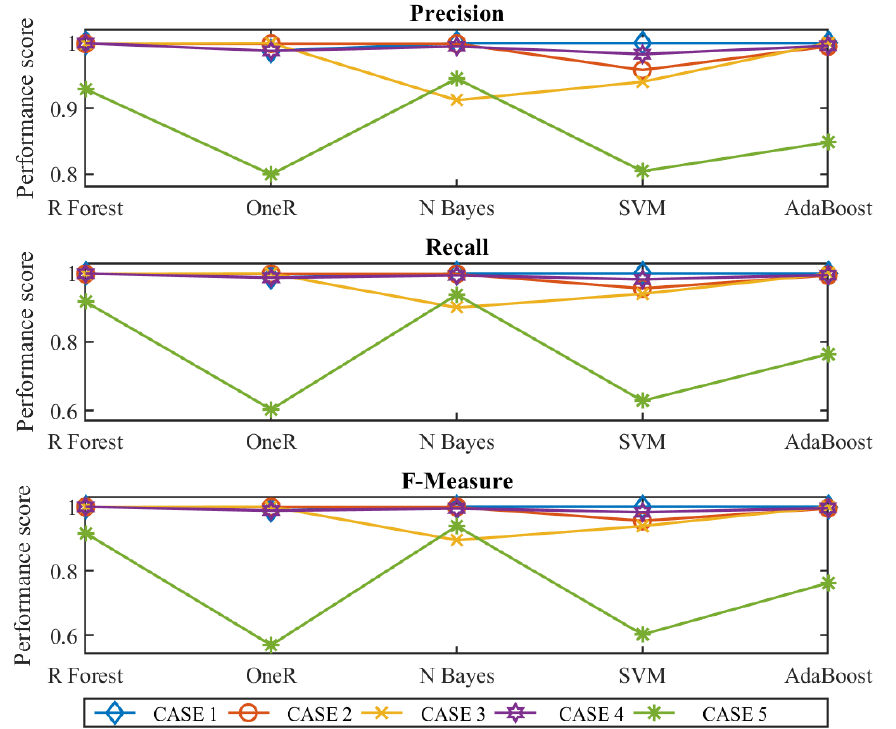
Figure 6. Precision, Recall, and F-measure of different machine learning algorithms for different case